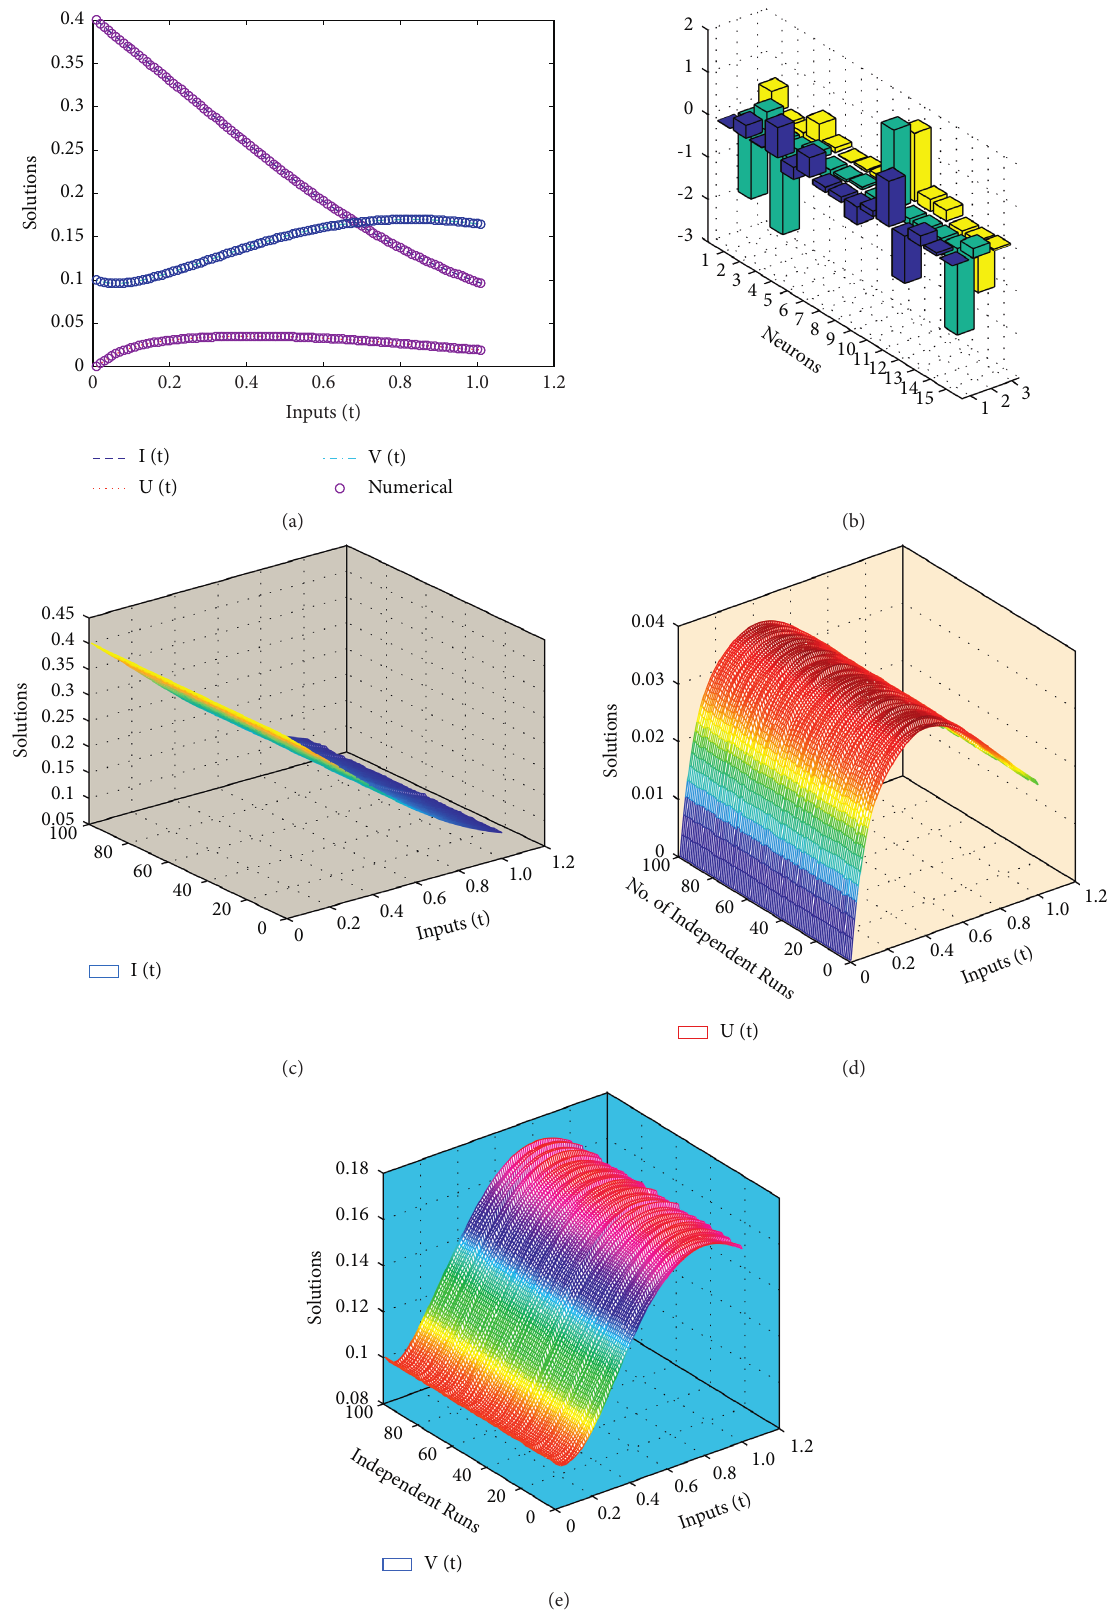
Figure 4: Problem 2: graphical evaluation for tumor growth ratio ( r ) to rate of cell lysis ( δ ) f � 0, the inverse of burst size parameter g � 0 . 02, and the viral decay ( α ) ratio to rate of cell lysis ( δ ) h � 0 . 15. (a) Solution for f � 0, g � 0.02, and h � 0.15 with initial conditions I (0) � 0.4, U (0) � 0, and V (0) � 0.1, (b) weights obtained by ANN-SCA-SQP for CVRT, (c) solutions of 100 independent runs of I ( t ), (d) solutions of 100 independent runs of U ( t ), and (e) solutions of 100 independent runs of V ( t